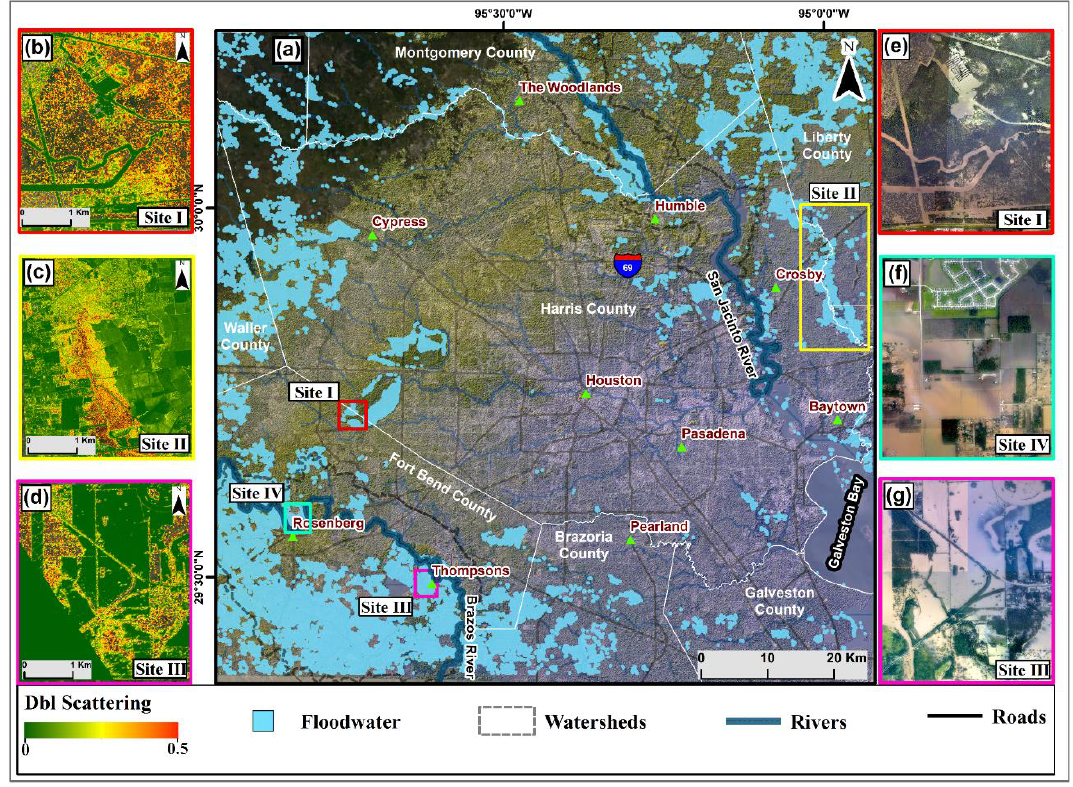
Figure 6. Validation of the Sentinel-1-based flood-prone areas using unsupervised classification applied to the Uninhabited Aerial Vehicle Synthetic Aperture Radar (UAVSAR) images (Figure 6a–d) and National Oceanic and Atmospheric Administration (NOAA) aerial photos acquired during Hurricane Harvey (Figure 6e–g). Four sites (Sites I–IV) in different parts of the study area were selected to demonstrate the reliability of the floodwater detection approach using Sentinel-1 data as the input. Two sites in which there is an overlap of UAVSAR and NOAA aerial image acquisitions (Sites I and III) were selected to correlate the flood mapping from the two sources and to further demonstrate the accuracy of the proposed approach.